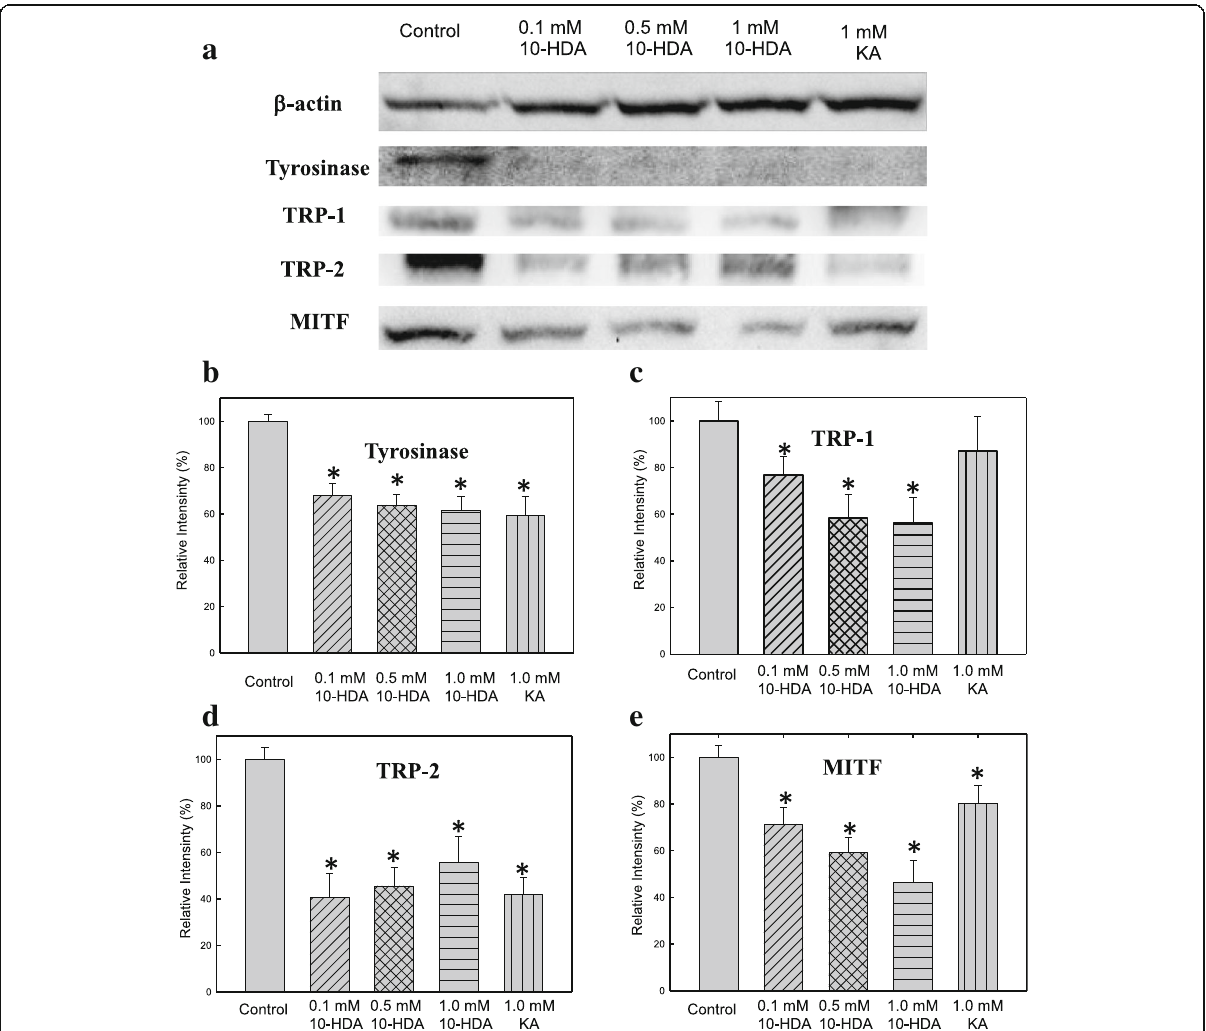
Fig. 4 Effect of 10-HDA on melanogenic protein expression in B16F1 melanoma cells. Cellular protein expression patterns in the B16F1 melanoma cell lysates were analyzed by western blot: ( a ) Densitometric analysis was performed using NIH image analysis software for ( b ) tyrosinase, ( c ) TRP-1, ( d ) TRP-2 and ( e ) MITF. The relative band intensity of the enzymes was normalized by β -actin. * P < 0.05 is considered to be